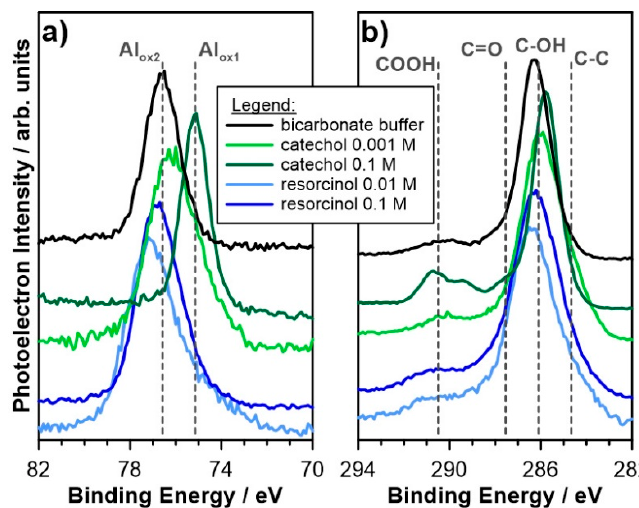
Figure 4. High-resolution XPS spectra recorded in ( a ) Al2p and ( b ) C1s binding energy range for aluminum alloy 5754 after 24 h exposure in bicarbonate buffer (pH = 11) and bicarbonate buffer with the addition of resorcinol or catechol at concentrations 10 and 100 mM.